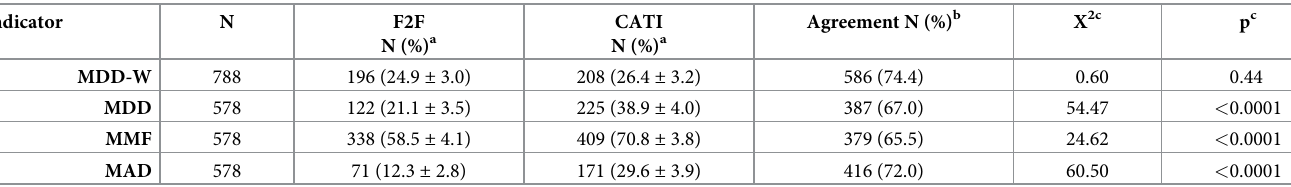
a Number (N) and percentage (%) of respondents who met the threshold for adequate nutrition for the given indicator via each data mode. Confidence intervals around the percentage meeting the threshold were calculated using the Clopper-Pearson exact method. b Number (N) and percentage (%) of participants whose indicator status did not change between modes. c Based on McNemar’s Exact Test on respondents’ indicator status.